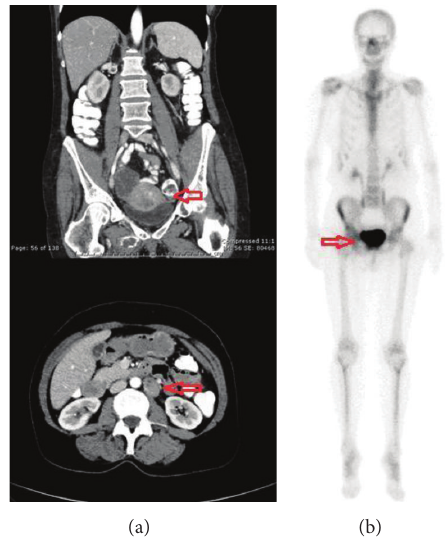
Figure 1: MRI (a) and bone scan (b) of uterine mass metastatic to